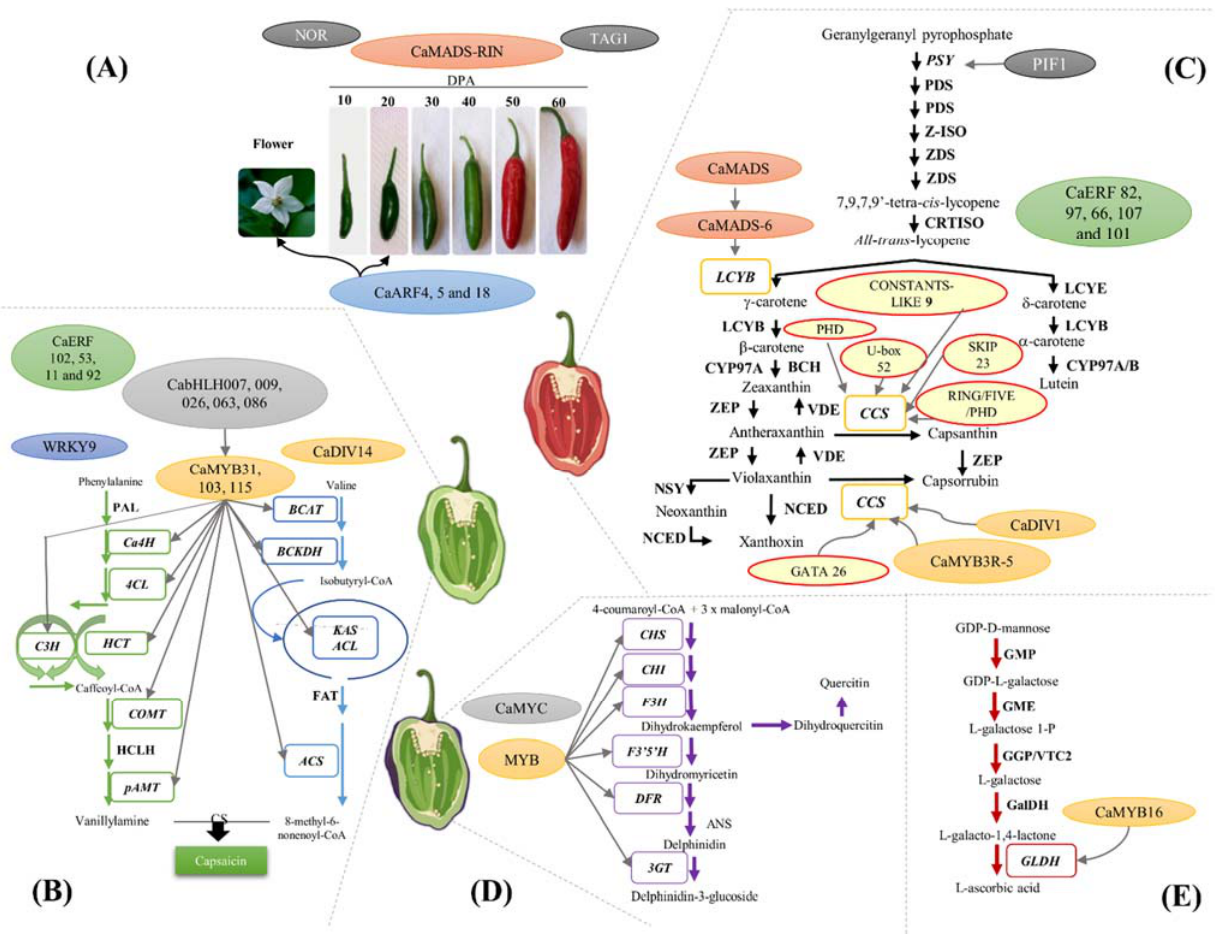
Figure 2. Transcription factors involved in the ripening process of Capsicum spp. ( A ) Chili pepper fruit development. Days post-anthesis (DPA). ( B ) Capsaicinoid biosynthetic pathway. Phenylalanine ammonia lyase (PAL), cinnamate 4-hydroxylase (Ca4H), 4-coumaroyl-CoAligase (4CL), hydroxycinnamoyl transferase (HCT), coumaroyl shikimate/quinate3-hydroxylase (C3H), caffeic acid O -methyltransferase (COMT), caffeoyl-CoA 3- O -methyltransferase (HCLH), aminotransferase (pAMT), branched-chain amino acid transferase (BCAT), isovalerate dehydrogenase (BCKDH), ketoacyl-ACPsynthase (KAS), acyl carrier protein (ACL), acyl-ACP thioesterase (FAT), acyl-CoA synthetase (ACS), and capsaicinoid synthase (CS). ( C ) Carotenoid biosynthetic pathway. Phytoene synthase (PSY), phytoene desaturase (PDS), ζ -carotene isomerase (Z-ISO), ζ -carotene desaturase (ZDS), carotene isomerase (CRTISO), β -lycopene cyclase (LCYB), ε -lycopene cyclase (LCYE), β -carotene hydroxylase (BCH), β -carotene hydroxylase cytochrome 450 type A and B (CYP), zeaxanthin epoxidase (ZEP), violaxanthin epoxidase (VDE), capsanthin-capsorubin synthase (CCS), neoxanthin synthase (NSY), and 9- cis -epoxycarotenoid dioxygenase (NCED). ( D ) Anthocyanin biosynthetic pathway. Chalcone synthase (CHS), chalcone isomerase (CHI), flavanone 3-hydroxylase (F3H), flavonoid 3 ′ -hydroxylase (F3 ′ H), flavonoid-3 ′ ,5 ′ -hydroxylase (F3 ′ 5 ′ H), dihydroflavonol 4-reductase (DFR), anthocyanidin synthase (ANS), and UFGT: UDP-Glc-flavonoid 3-O-glucosyl transferase (3GT). ( E ) L-ascorbic acid biosynthetic pathway. GDP-D-mannose pyrophosphorylase (GMP), GDP-D-mannose-3 ′ ,5 ′ -epimerase (GME), GDP-L-galactose phosphorylase (GGP/VTC2), L-galactose-1-dehydrogenase (GalDH), and L-galactano-1,4-lactone dehydrogenase (GLDH).